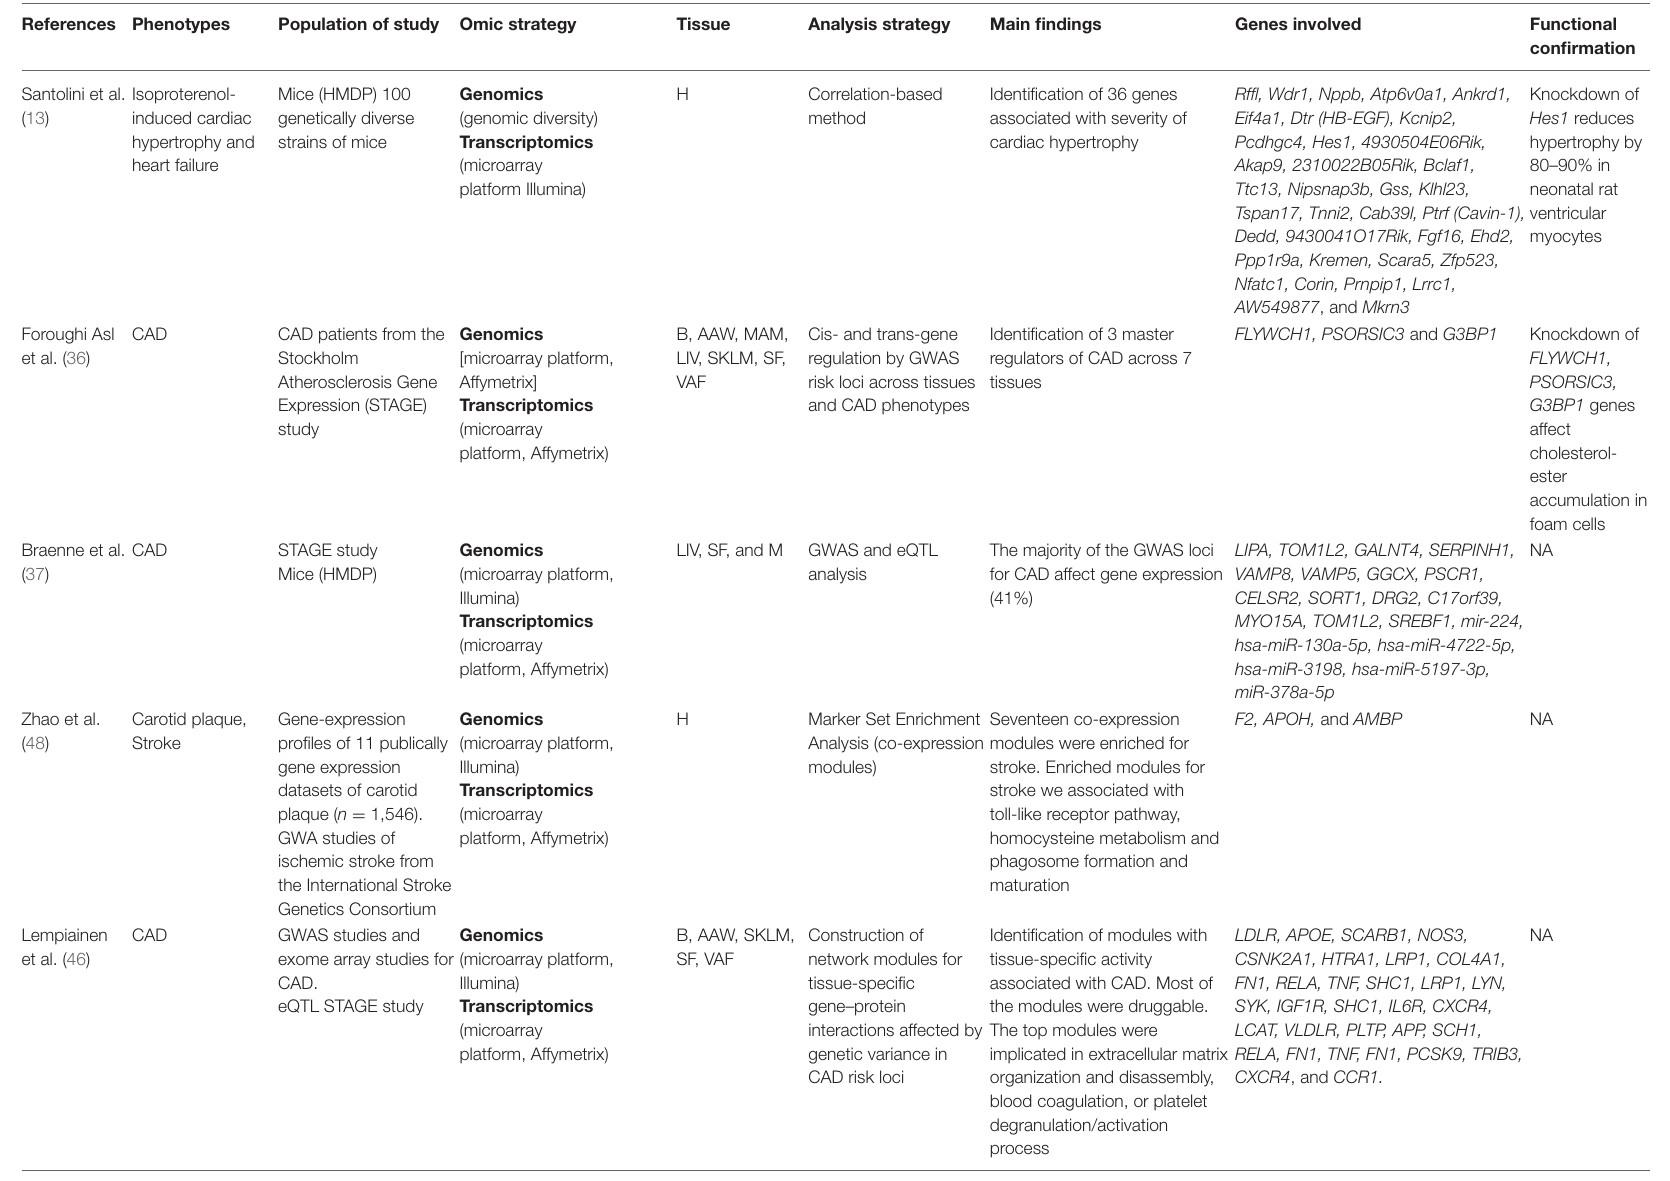
TABLE 1 | Studies using Multi-omics approaches for the investigation of cardiovascular